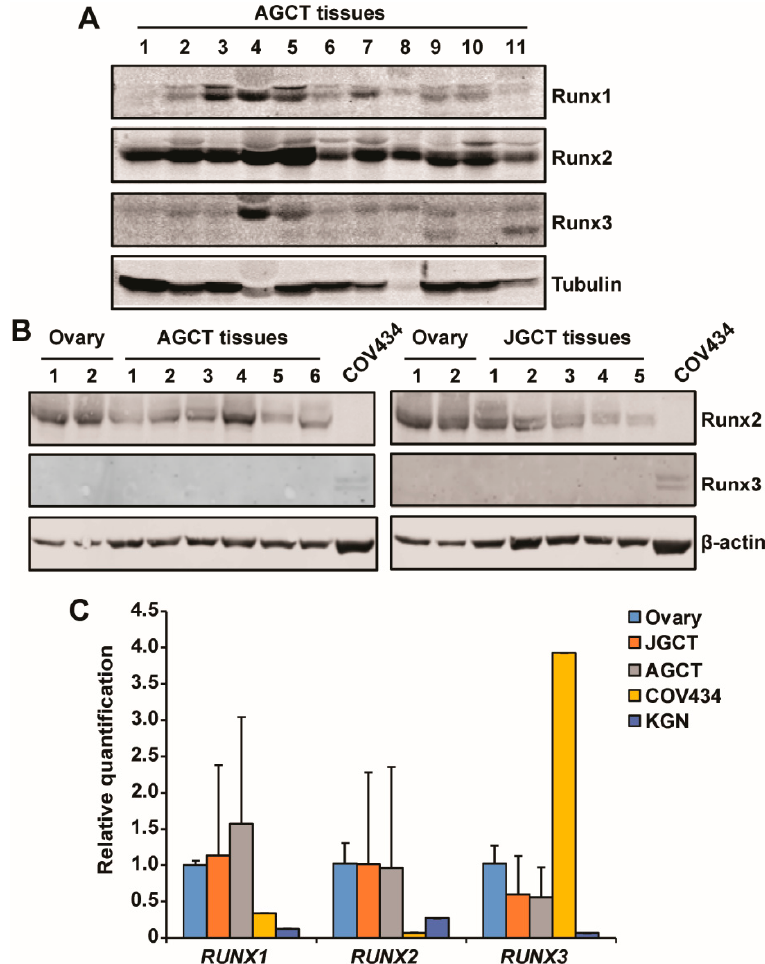
Figure 5. Expression of RUNX proteins in human GCT tissues. ( A ) The expression of RUNX proteins in human adult GCT tissues was examined by immunoblotting. Tubulin was used as the loading control. ( B ) The expression of RUNX2 and RUNX3 in human adult and juvenile GCT tissues, as well as the normal ovary, was examined by immunoblotting. β -actin was used as the loading control. ( C ) The mRNA level of RUNX1, RUNX2, and RUNX3 in human adult and juvenile GCT tissues, as well as the normal ovary, was examined by qRT-PCR and expressed as the relative quantification against that in the normal ovary. Data for the normal ovary and GCT tissues are shown as mean ± SD ( n = 3 for ovary; n = 5 for JGCT; and n = 6 for AGCT).